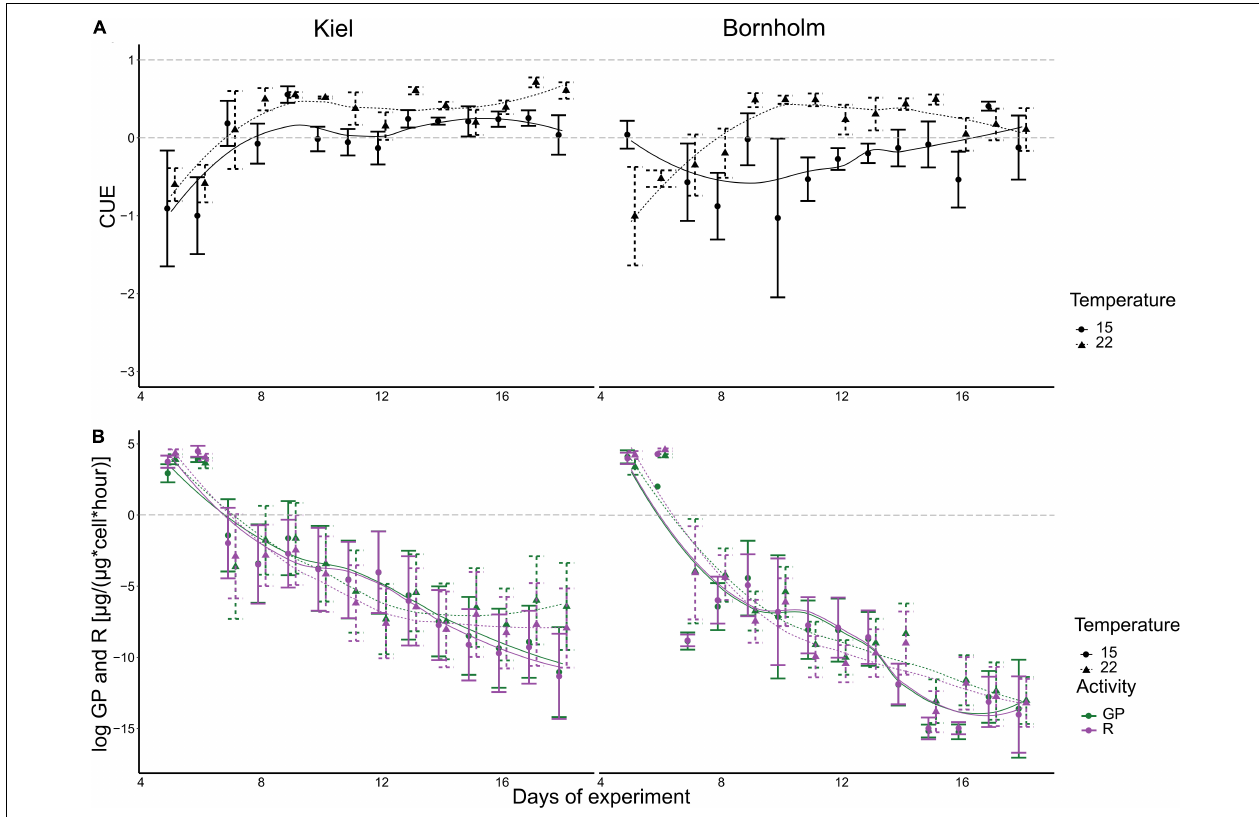
FIGURE 3 | CUE (A) , gross photosynthesis (green) and respiration (purple) (B) are shown here. The left panels show data for Kiel strains, whereas the right panels show data of Bornholm strains. All points show mean ± 1 SE including n = 12 and n = 12 for Kiel and Bornholm, respectively. The fitted lines are based on a loess smoother. The dashed gray lines indicate thresholds for CUE where either no growth on CO 2 alone is possible ( < 0), some growth is possible (0–0.5) and growth on CO 2 alone is possible ( >